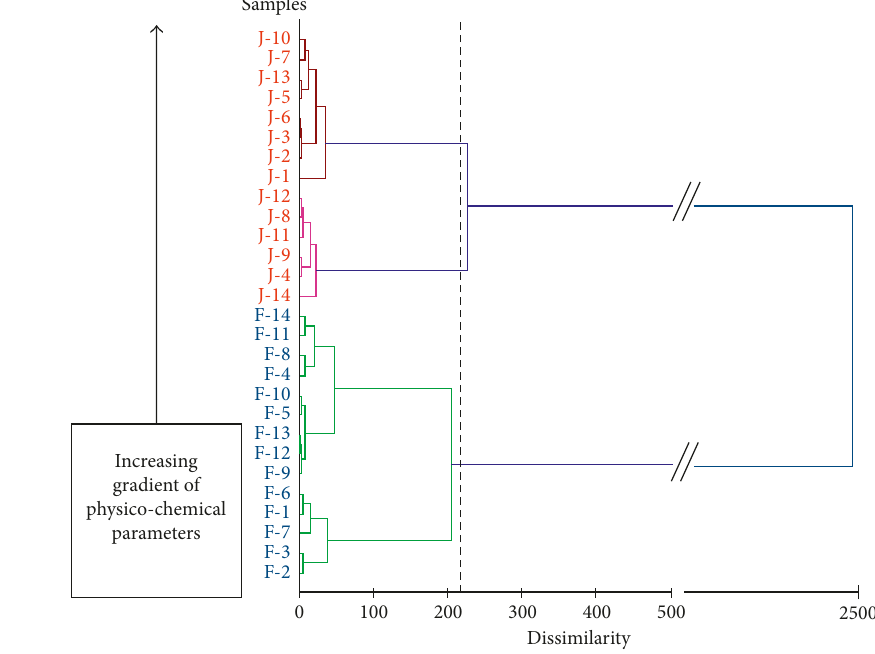
Figure 12: Dendrogram for the South Lagoon of Tunis samples.